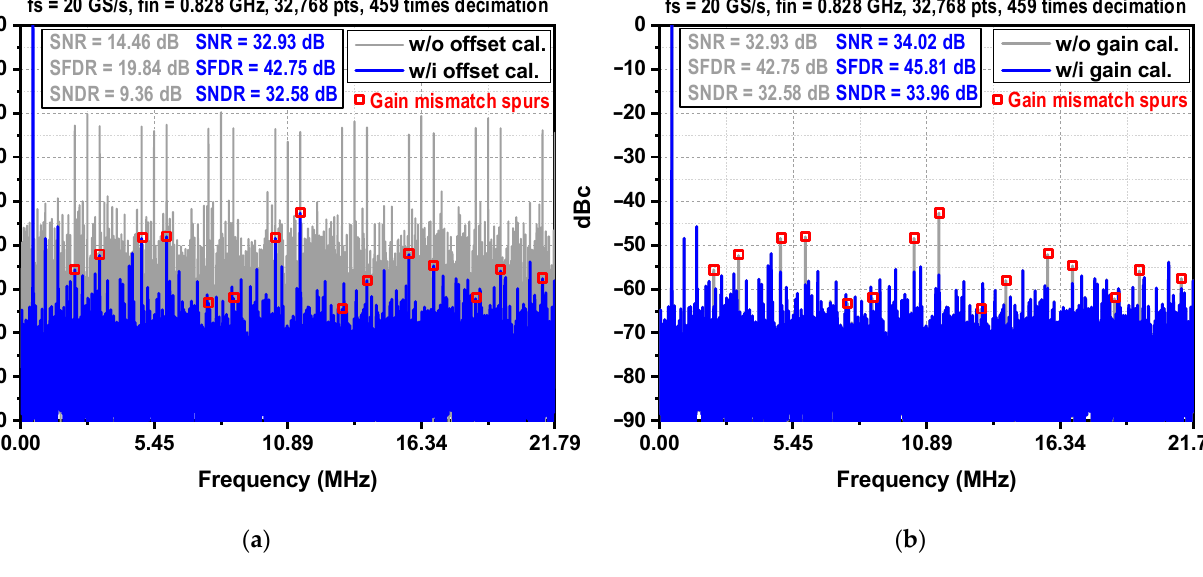
Figure 16. Measured FFT spectra with a 0.828 GHz input at a 20 GS/s sampling rate. ( a ) With and without calibration for mismatches of comparators and VTCs. ( b ) With and without calibration for gain mismatch between the interleaving channels.